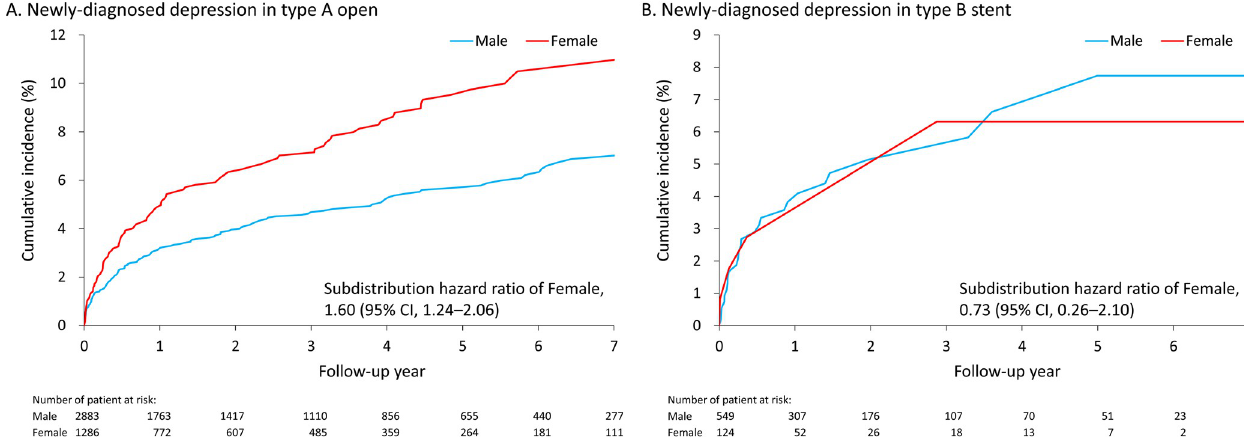
Fig 3. The cumulative incidence function of newly-diagnosed depression in the female and male patients who received type A open surgery (A) and type B stent surgery (B) by using the raw data for real-world practice. The subdistribution hazard ratio was not adjusted for any covariates.